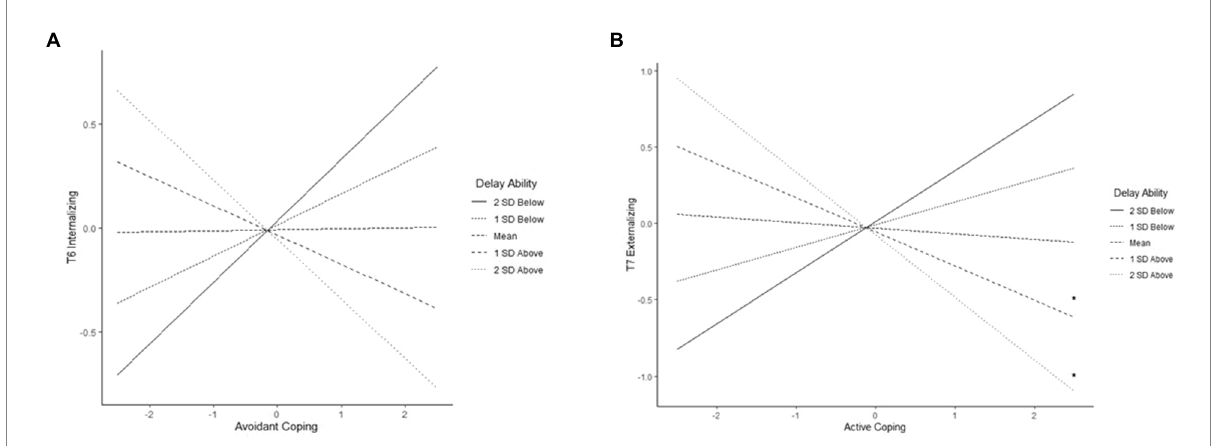
FIGURE 4 Delay ability moderating the associations of (A) avoidant coping with T6 internalizing and (B) active coping with T7 externalizing (* p < 0.05, ** p <